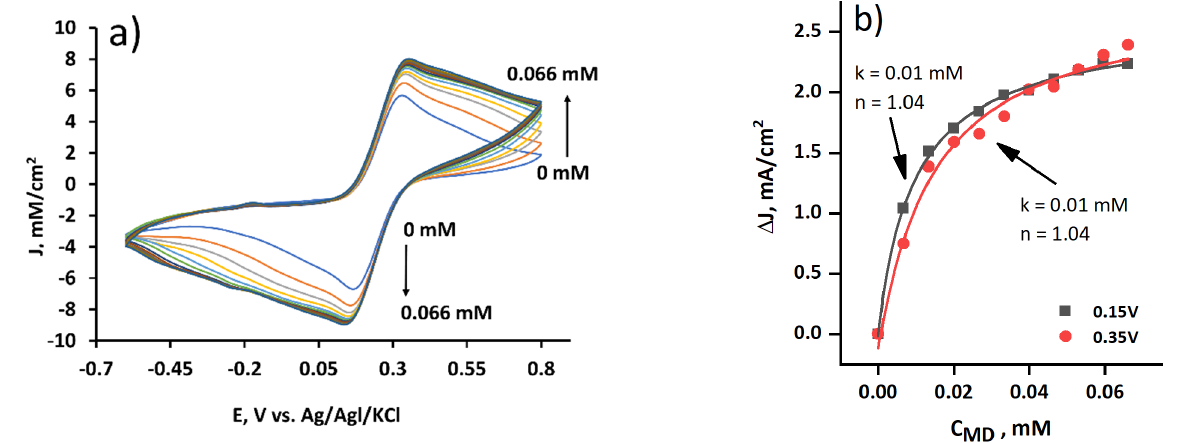
Figure 4. ( a ) Cyclic voltammograms registered by the yeast-modified graphite electrode at different MD concentrations.